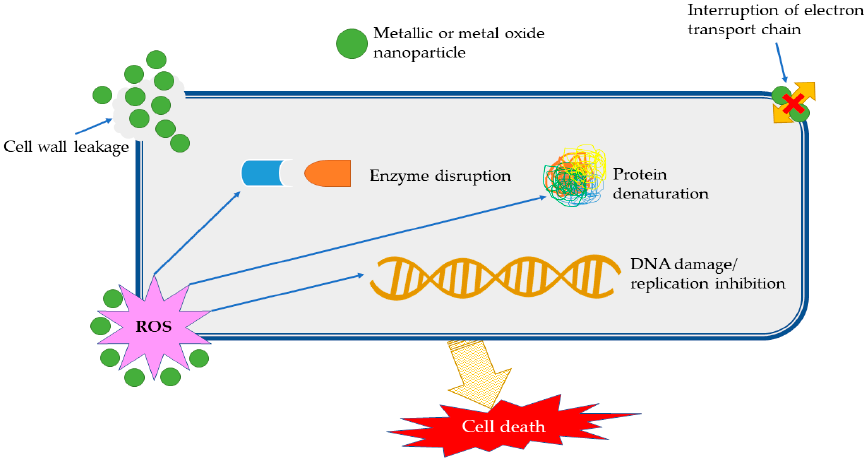
Figure 2. Antimicrobial mechanism of nanoparticles (adapted from [9–12]).